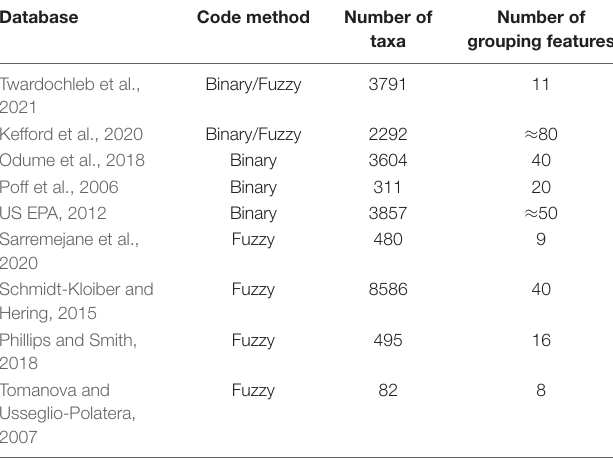
TABLE 1 | Detailed information contained in the